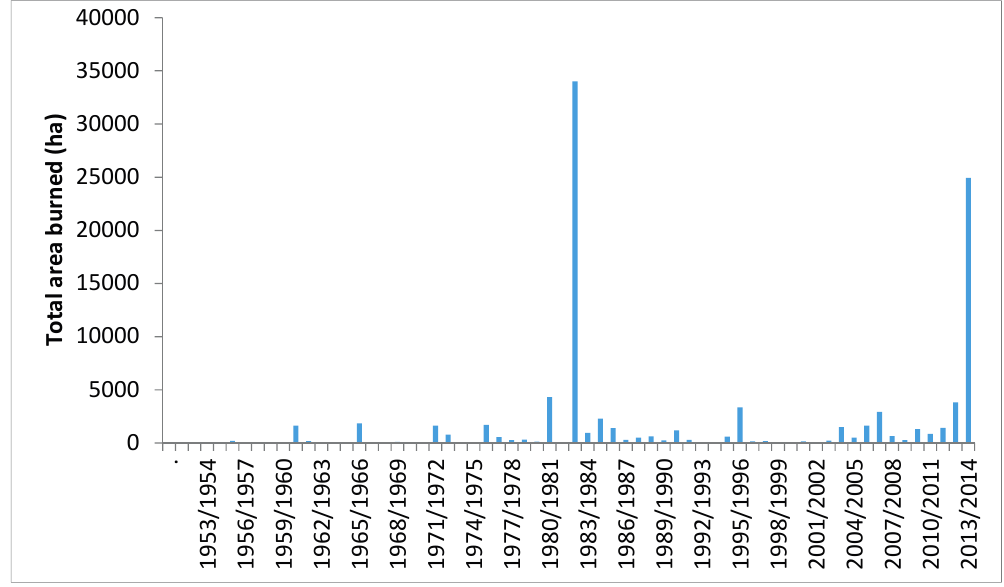
Figure 5. Areas burned each fire season by ( a ) all fires and ( b ) prescribed fires only, from 1951–1952 to 2013–2014. Note the difference in the vertical